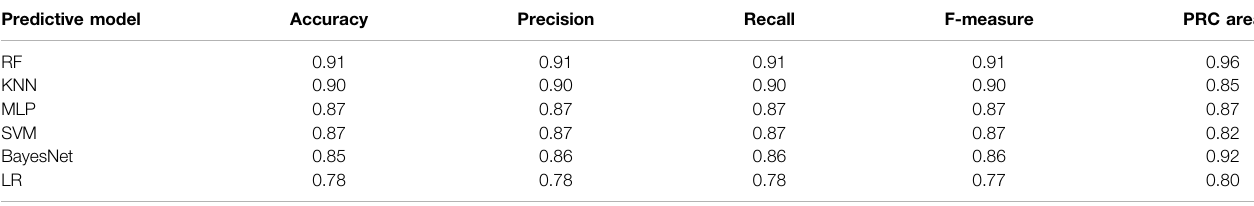
TABLE 4 | Comparison of predictive models for prediction of students ’ performances on third module quizzes. Predictive model